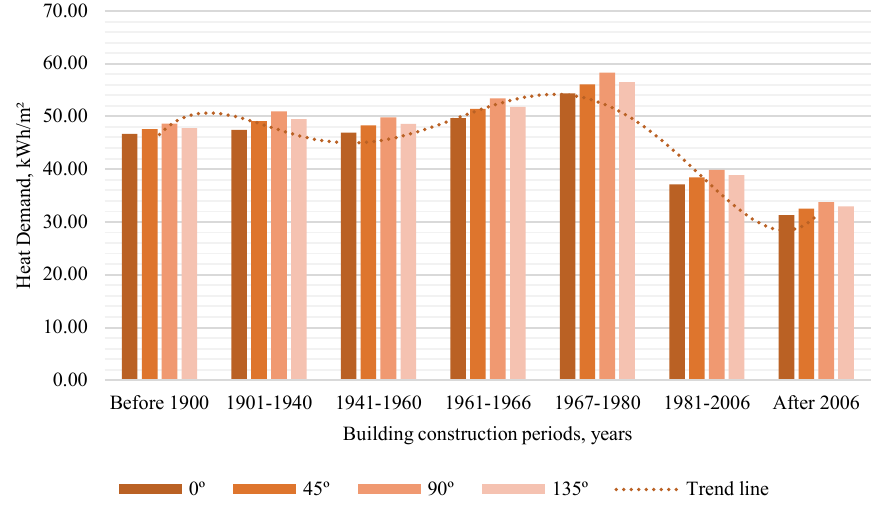
Fig. 3. Heating demand variation according to the building orientation and construction period